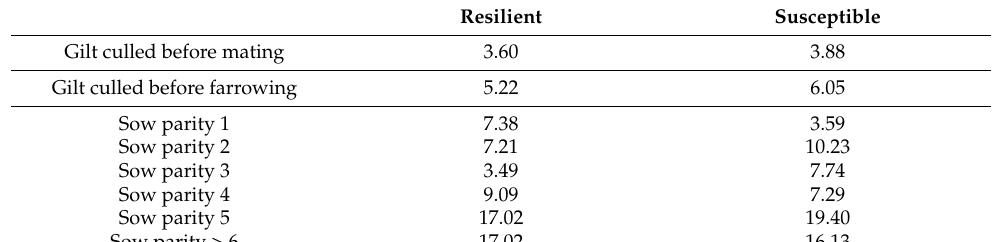
Table 5. Culling rates (%) of involuntary (mortality and euthanized at farm by humanitarian reasons) and voluntary (sows sent to abattoir or slaughtered sows) decisions from the data in the included farm from March 2016 to March 2019. Rates were obtained by splitting the sows according to the phenotypes of resilient and susceptible. Resilient